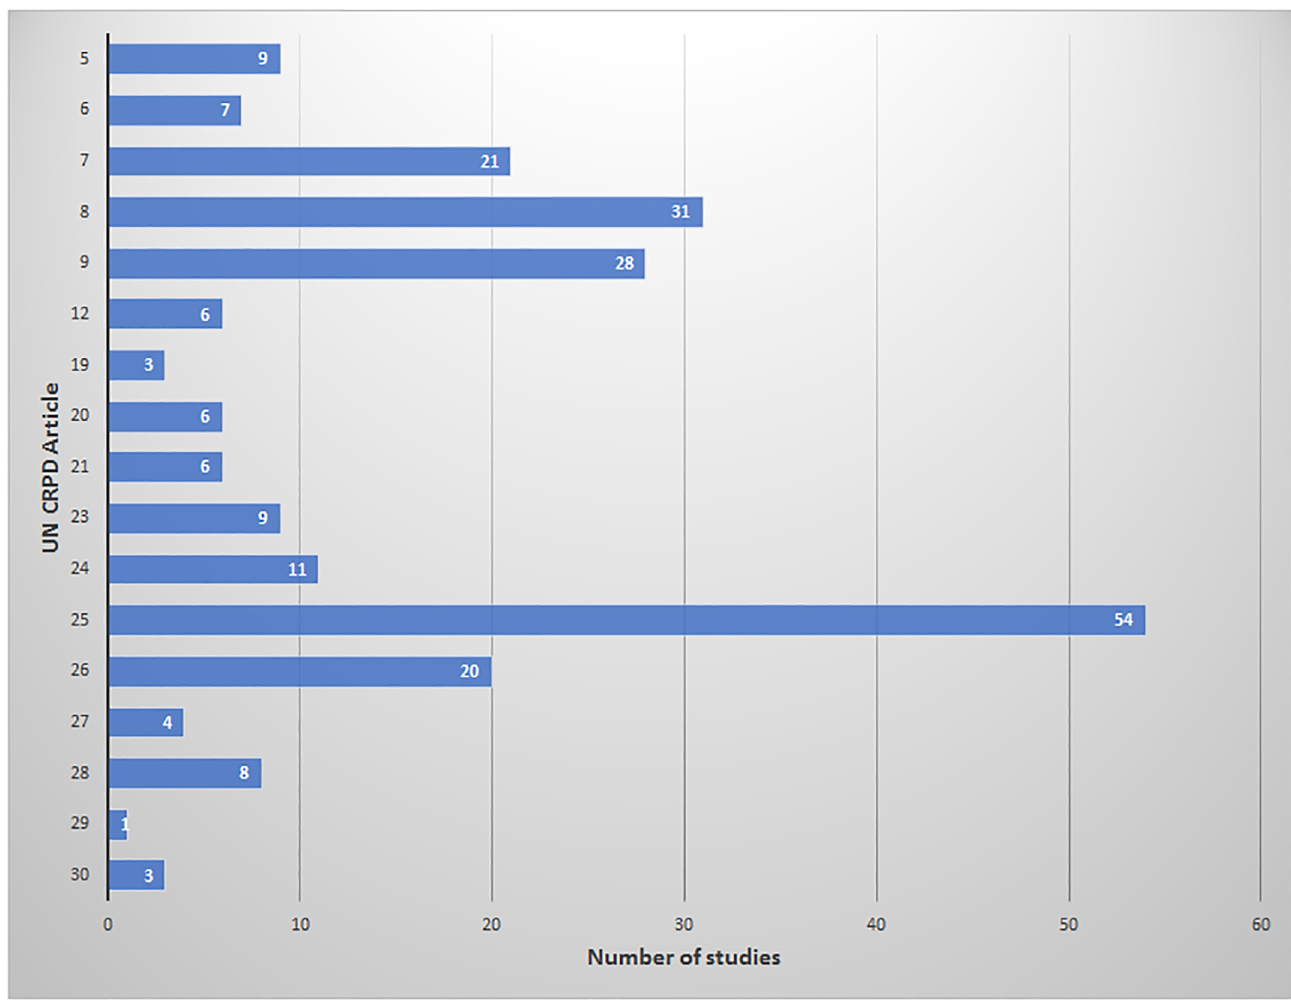
Fig 2. Number of studies published per UN CRPD